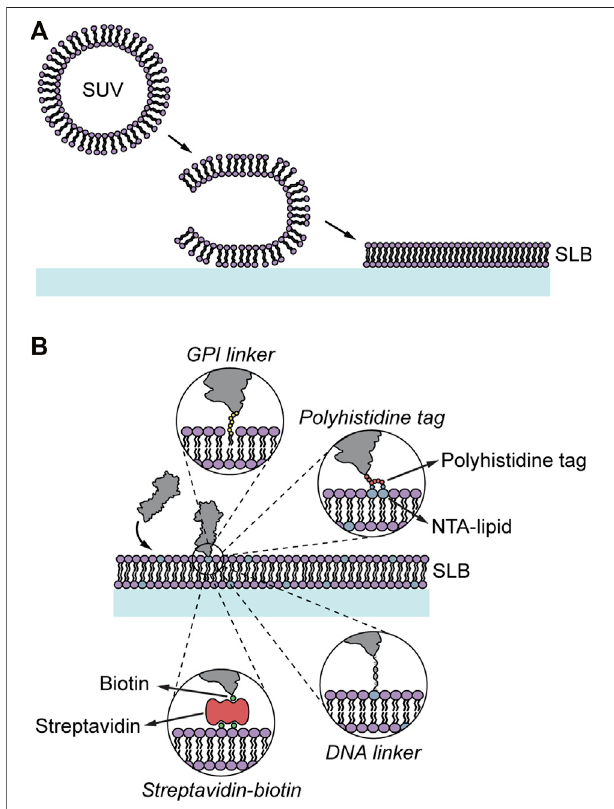
FIGURE 2 | Formation and modi fi cation of SLBs. (A) SLB formation through vesicle adsorption and rupture. The vesicles adsorb onto a clean glass support, where they rupture and unfold forming an SLB. (B) SLBs can befunctionalizedwithproteinsusingdifferentanchorstrategiesincluding GPI linkers, nickel-chelating lipids binding polyhistine-tagged proteins, biotinylated lipids binding, via streptavidin, biotinylated proteins, and DNA